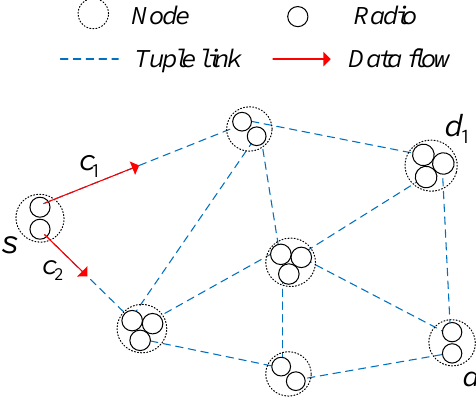
Figure 1. The multicommodity flow problem based on a tuple-based link model.